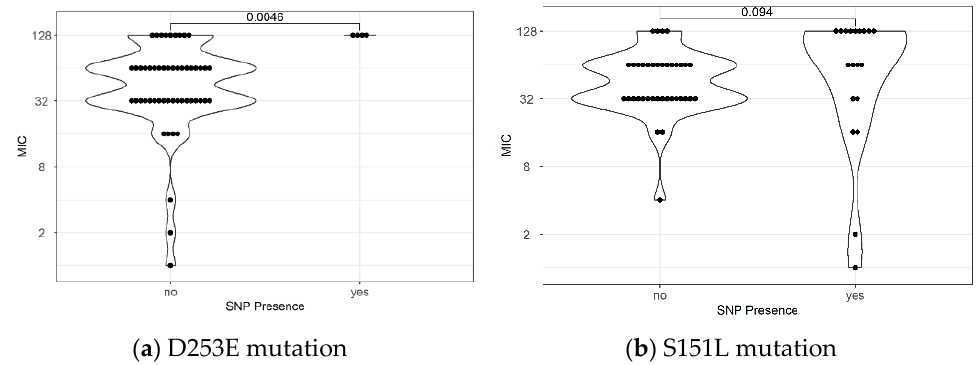
Figure 3. Comparison of metronidazole MIC in the presence and absence of mutations: All isolates possessing D253E mutation showed a high level of resistance (MIC 128 mg/L) ( a ). Meanwhile, the majority of high-level resistance possessed the S151L mutations ( b ).